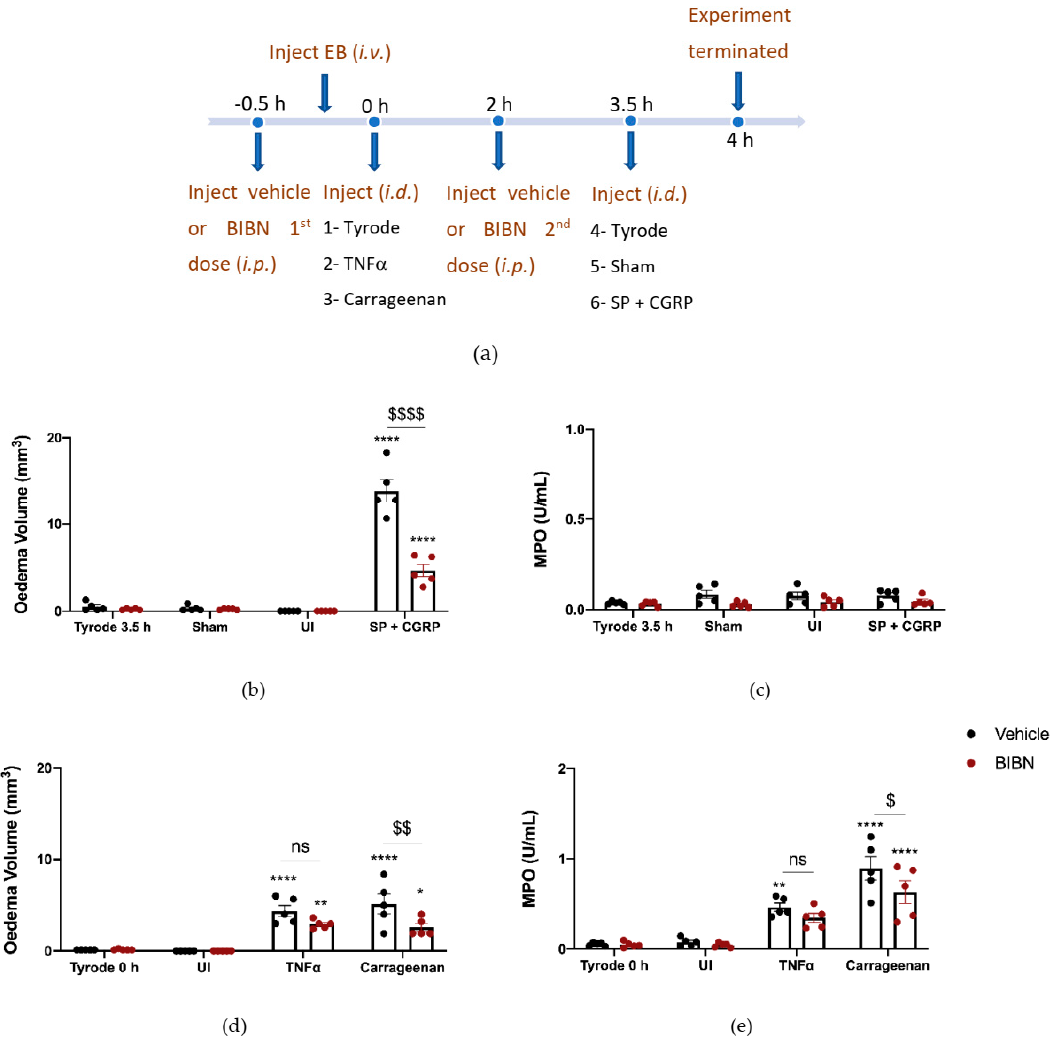
Figure 5. Calcitonin gene-related peptide, CGRP, receptor antagonist, BIBN4096BS, reduces oedema formation and neutrophil accumulation induced by carrageenan but not tumour necrosis factor alpha (TNF α )-induced inflammation over 4 h. ( a ) Timeline for studying the effect of the CGRP antagonist BIBN4096BS (3 mg/kg i.p., given at − 0.5 h and at 2 h) on TNF α and carrageenan-induced inflammation over 4 h. Oedema volume ( b ) and neutrophil accumulation ( c ) measured after injecting the positive control SP (300 pmol/50 µ L) with CGRP (20 pmol/50 µ L i.d.) at the last 30 min of the protocol. ( d ) Oedema volume and ( e ) neutrophil accumulation measured 4 h after injecting TNF α (100 ng/50 µ L i.d.) and carrageenan (100 µ g/50 µ L i.d.) in vehicle or BIBN4096BS pre-treated mice. Results are shown as mean ± SEM ( n = 5). Two-way ANOVA with Bonferroni’s post hoc test. * p < 0.05 and ** p < 0.01 and **** p < 0.0001 are compared to Tyrode 0 h or Tyrode 3.5 h. $ p <0.05, $$ p <0.01 and $$$$ p <0.0001 are compared to Vehicle SP + CGRP or